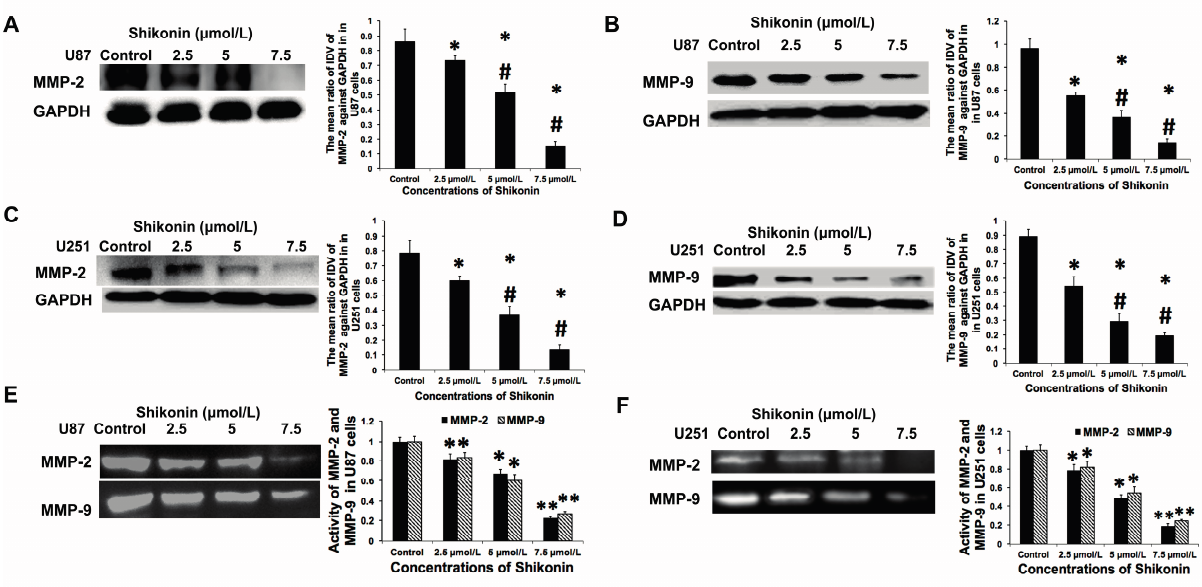
Figure 4. Shikonin inhibited the expression and activity of MMP-2 and MMP-9. U87 and U251 cells were treated with shikonin at 2.5, 5, and 7.5 μ mol/L for 48 h. Serum free DMEM served as a negative control. Expressions of MMP-2 and MMP-9 were checked with Western Blot. ( A ) Effects of shikonin on the expression of MMP-2 in U87 cells; ( B ) Effects of shikonin on the expression of MMP-9 in U87 cells; ( C ) The changing pattern of MMP-2 in U251 cells; ( D ) The changing pattern of MMP-9 in U251 cells; ( E ) Effects of shikonin on the activities of MMP-2 and MMP-9 in U87 cells; ( F ) Effects of shikonin on the activities of MMP-2 and MMP-9 in U251 cells. Statistical analysis showed that shikonin significantly reduced the expression levels and activity of both MMP-2 and MMP-9 proteins compared with the control group in a dose-dependent manner. * p < 0.05, ** p < 0.01 (compared with control group); # p < 0.05 (compared with 2.5 μ mol/L groups) ( n =